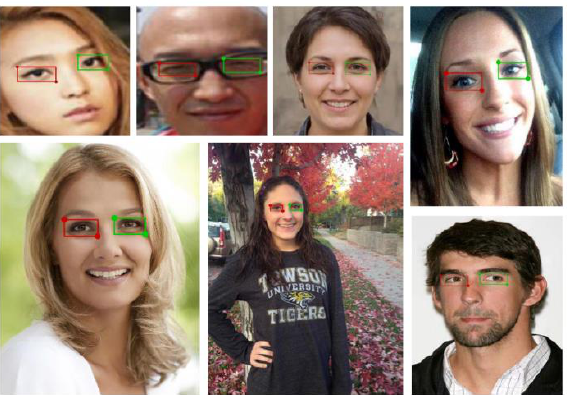
Figure 6. Sample images that are used in the proposed dataset. The images were segmented for eye focus, eye tracking, pupils, and iris. The data were created to develop a model for segmenting the elements in the eye images. Each element was labeled, then, for eye segmentation. The directory of the segmentation dataset is shown in Figure 7. The eye segmentation dataset consists of the left eye and the right eye and contains the original eye image and labeled images.